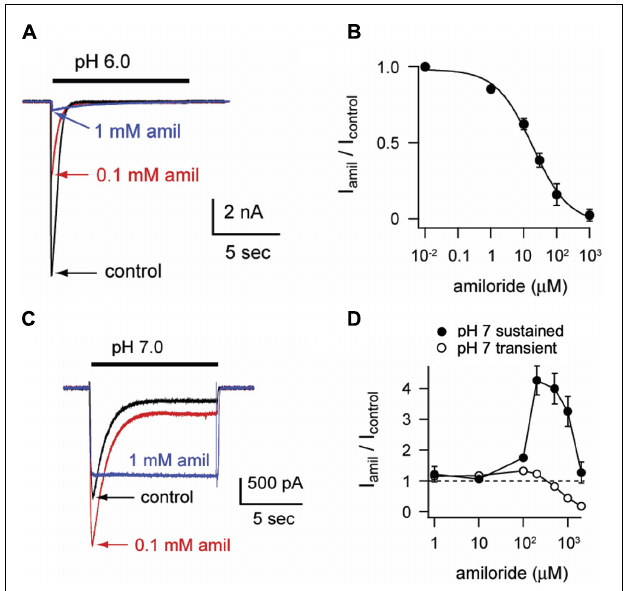
FIGURE 1 | Amiloride paradoxically inhibits or potentiates ASIC3. (A) Overlay of representative currents recorded from CHO cells transfected with ASIC3 evoked by stepping from pH 8 (containing no amiloride) to pH 6 in the absence (control) or presence of 100 µ M or 1 mM amiloride. (B) Dose-response curve for amiloride inhibition of pH 6-evoked currents. Line is fit of Hill equation (IC 50 = 18.6 µ M; n = 5–8 for each data point). (C) Overlay of pH-7 evoked currents in absence or presence of indicated amiloride concentrations. (D) Dose-responses of amiloride on the peak (transient) and sustained (measured at the end of 10 s pH 7 application) components of pH 7-evoked currents ( n = 8–11 for each data point). Note that data points above the dashed line represent amiloride potentiation and those below represent inhibition.